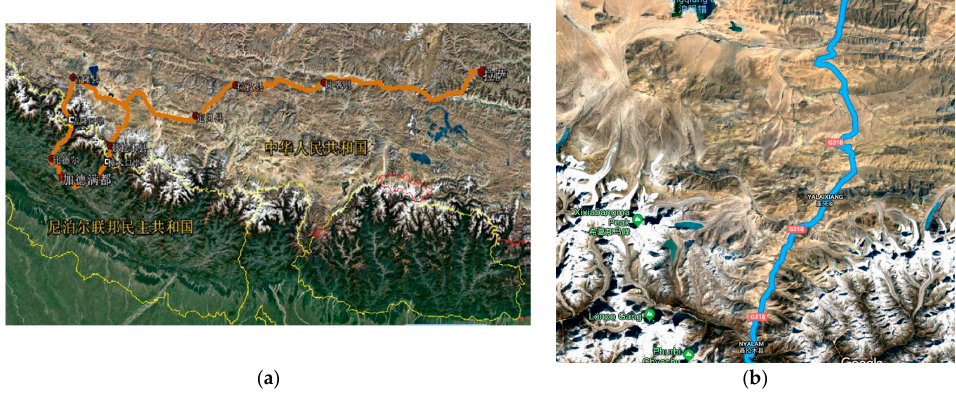
Figure 1. ( a ) map of the China-Nepal Highway; ( b ) Location map of the study area.